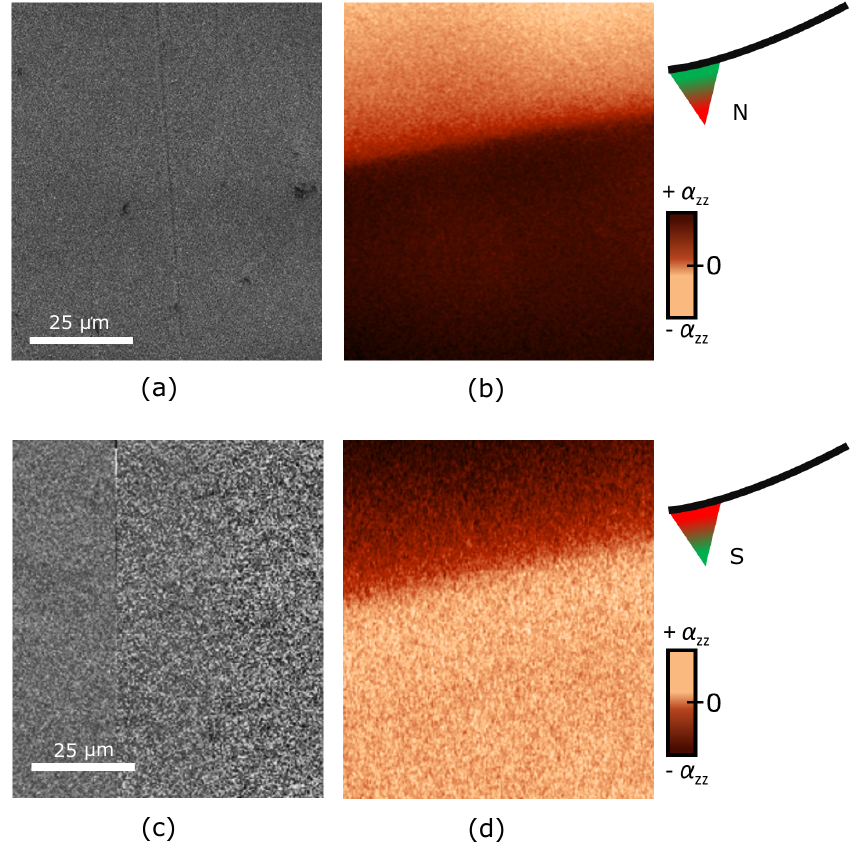
Figure 4. Effect of tip magnetization reversal. Pairs of topography and magnetoelectric images at 263K as in Figure 3 with ( a , b ) original tip magnetization (100nm image resolution) and ( c , d ) reversed magnetization (400nm image resolution). Identical areas were scanned before and after tip remagnetization; the relocation procedure for the tip is described in the